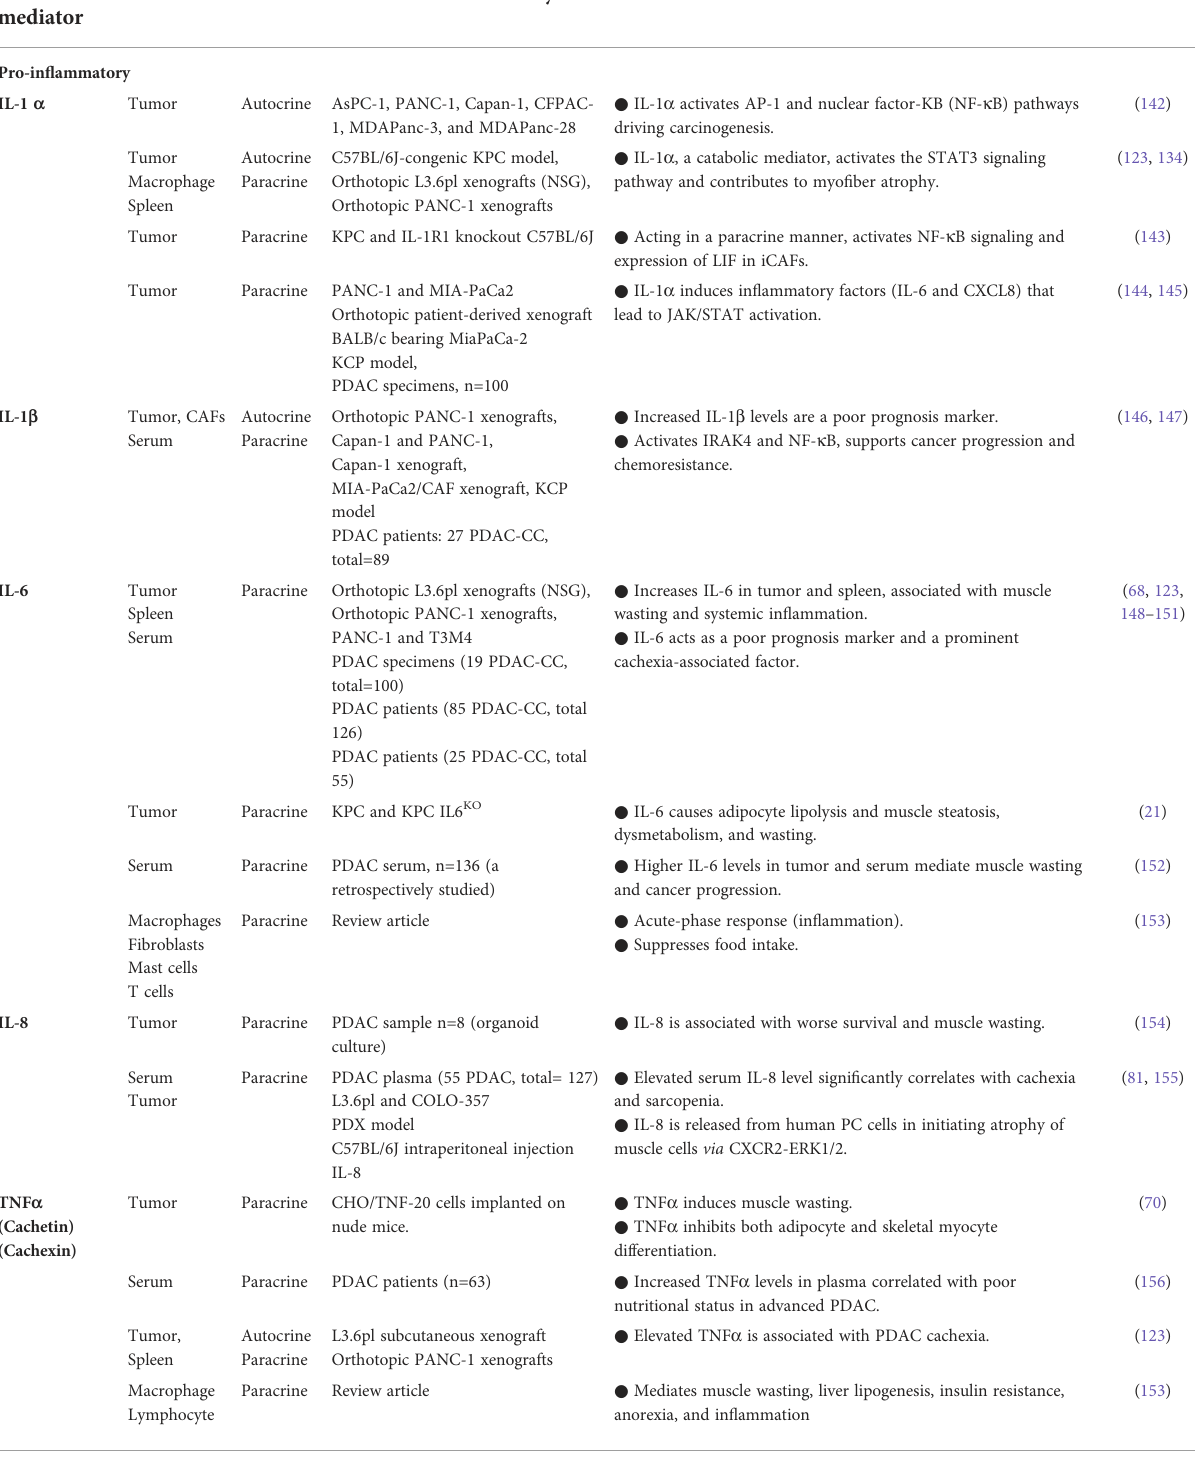
TABLE 5 Pro-cachectic mediators in PDAC-derived